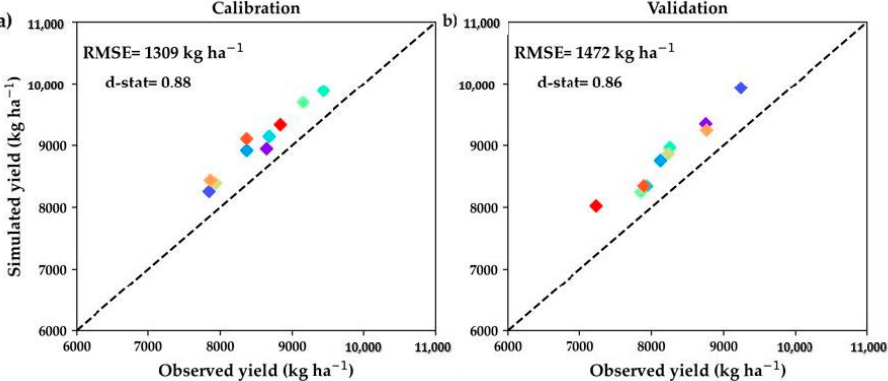
Figure 3. DSSAT CERES-Maize model ( a ) calibrated and ( b ) validated for the ten maize-producing counties of northeastern Kansas.